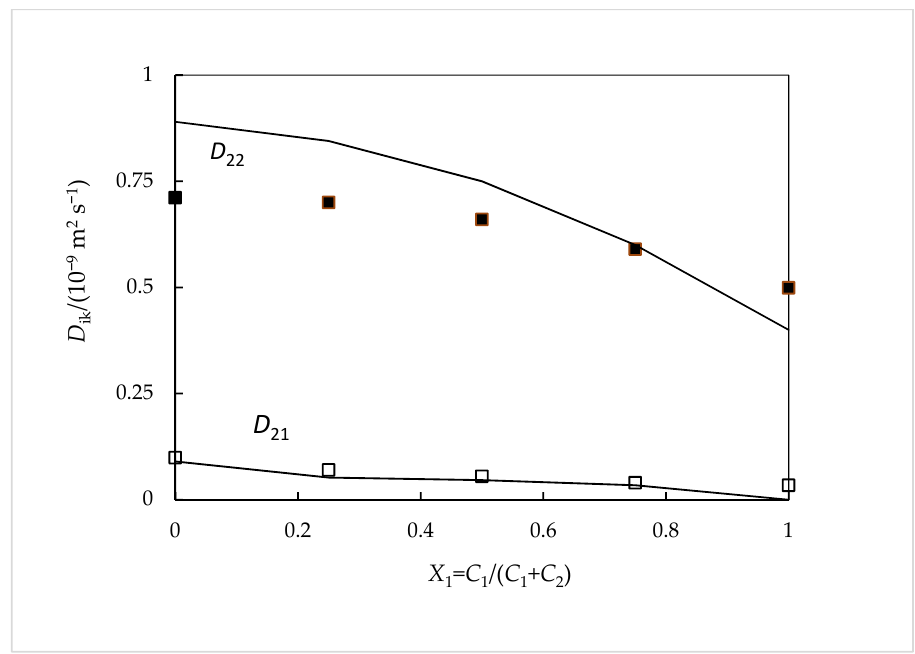
Figure 2. Ternary D ik coefficients for aqueous NaSal( C 1 ) + Na 4 EtRA( C 2 ) solutions containing 0.010 mol dm − 3 of total solute and their comparison with the predicted D ik coefficients calculated from the Nernst equations: D 21 , hollow squares; D 22 , filled squares. The solid curves represent Nernst predictions [15].